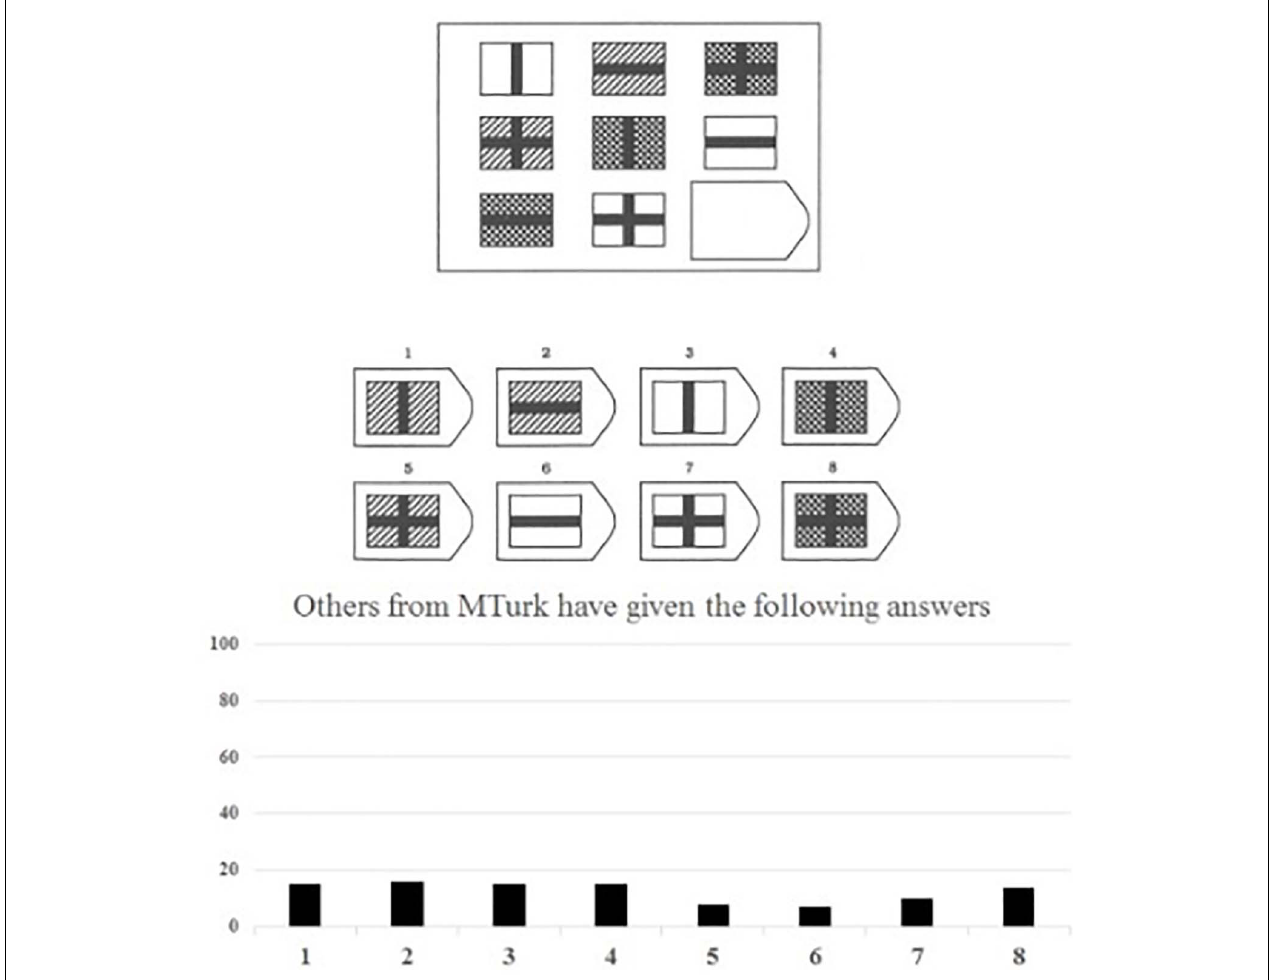
FIGURE 1 | Example of logical reasoning item (Item 4) with the fabricated diagram shown to the control condition. The Correct answer for the logical reasoning item (Item 4) is no